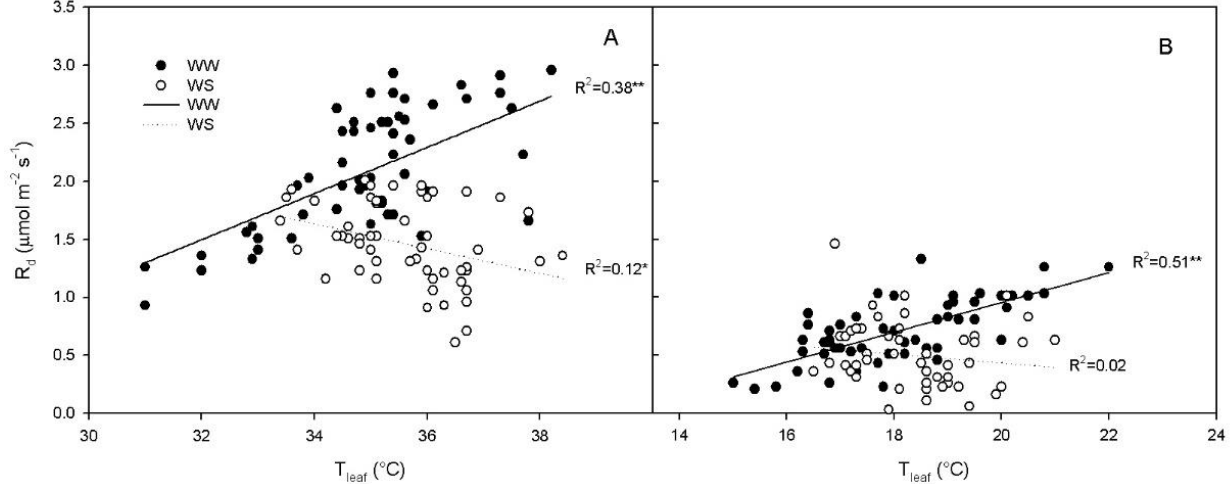
Figure 4. Relationship between leaf dark respiration (R d ) and leaf temperature (T leaf ) in well-watered (WW) and water stressed (WS) vines at ( A ) midday (y = − 4.87 + 0.20x, R 2 = 0.38 p < 0.0001; y = 5.26 − 0.10x, R 2 = 0.12 p = 0.01, respectively) and ( B ) at 4:00 a.m. (y = − 1.61 + 0.12x, R 2 = 0.51 p < 0.0001;